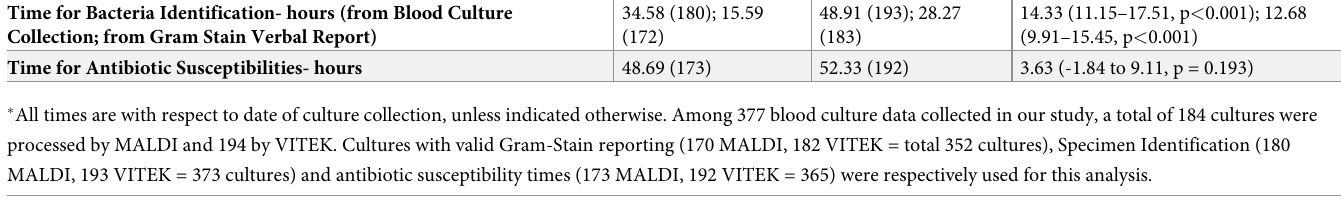
Table 2. Mean times gram stain verbal reporting, bacterial identification and antibiotic susceptibilities � . Testing Modality